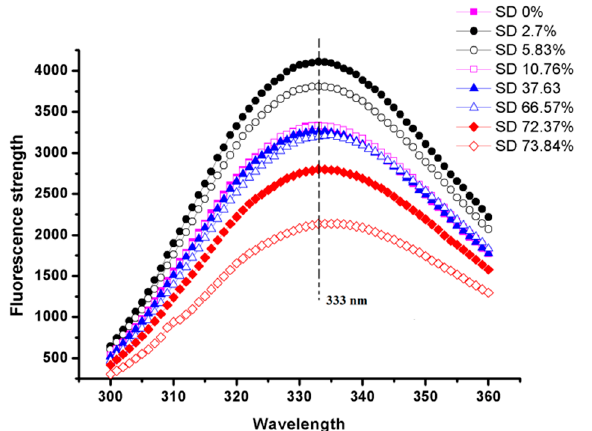
Figure 6. Intrinsic fluorescence spectra of EWP (0%) and SEWP with different succinylation degrees (2.7%, 5.83%, 10.76%, 37.63%, 66.57%, 72.37%, 73.84%).